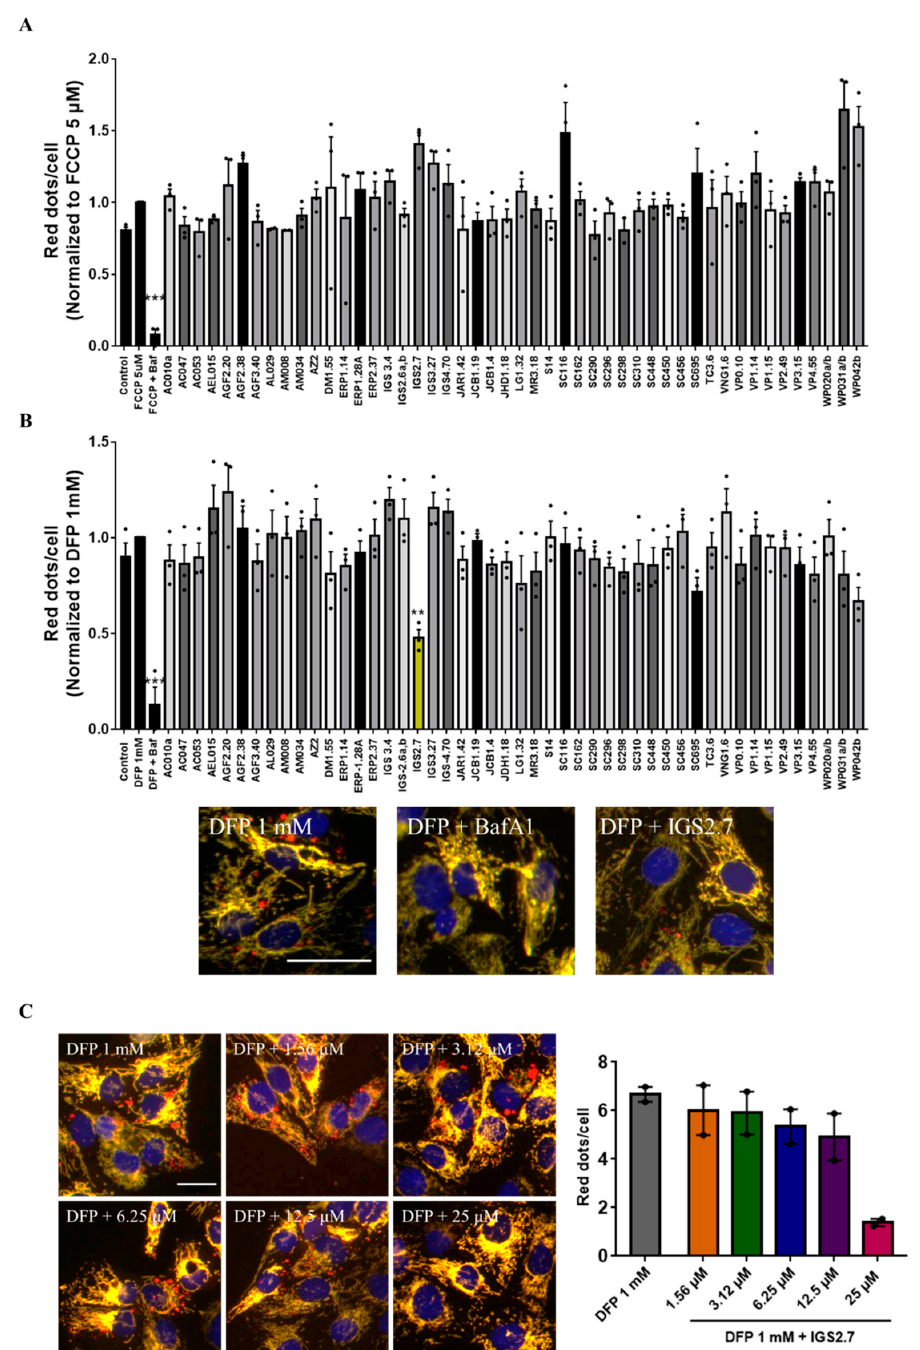
Figure 2. IGS2.7 inhibited DFP-induced mitophagy in U2OS-iMLS cells. ( A ) U2OS-iMLS-PRKN